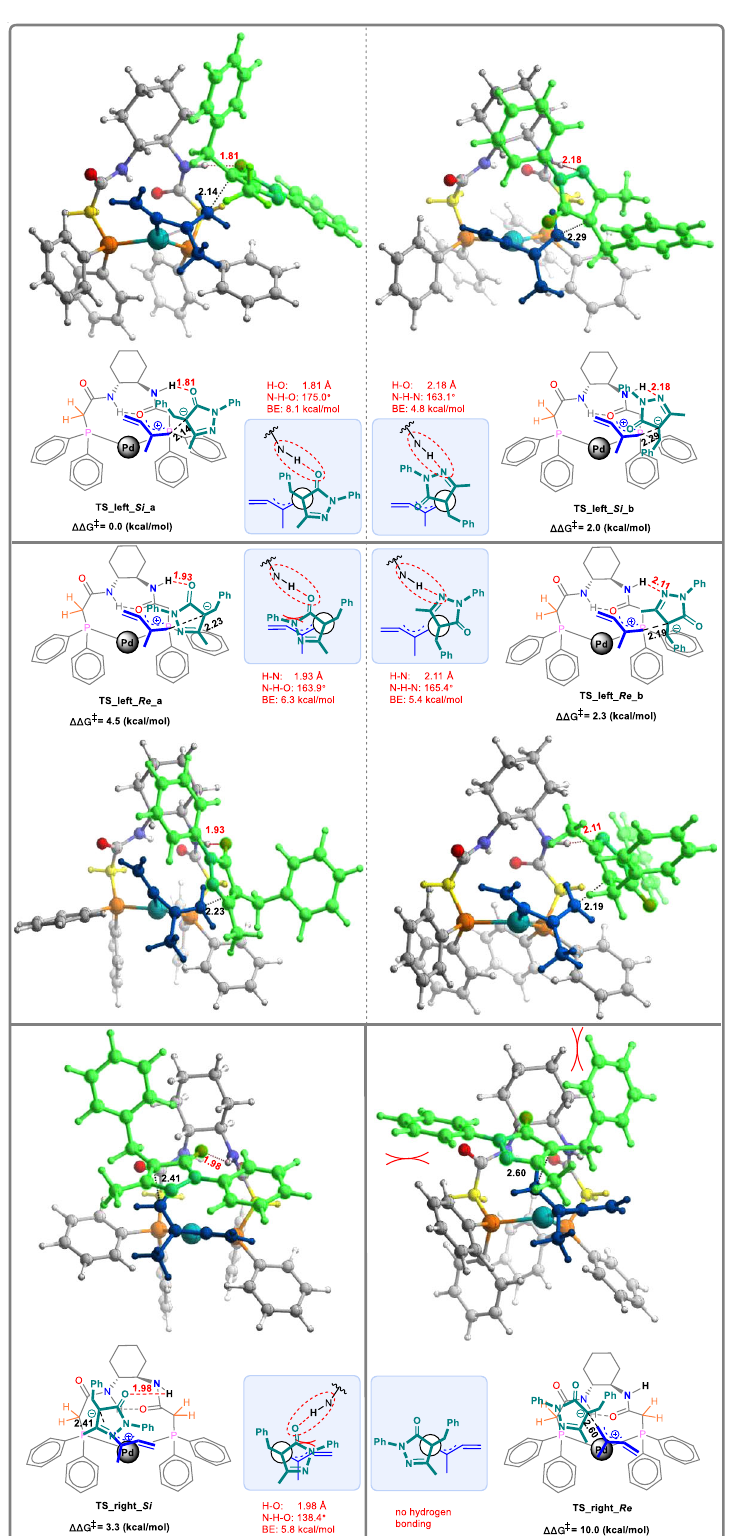
Fig. 6 DFT calculations for DACH-ZYC-Phos-C1-ligated palladium catalyst. DFT-optimized structures and relative energies of stereo-determining C − C bond formation transition states of the reaction of 1b with 2a catalyzed by the DACH-ZYC-Phos-C1 -ligated palladium catalyst. Hydrogen-bonding interactions are shown as red dash lines; selected bond lengths (Å) and bond angles (°) are listed. BE bond